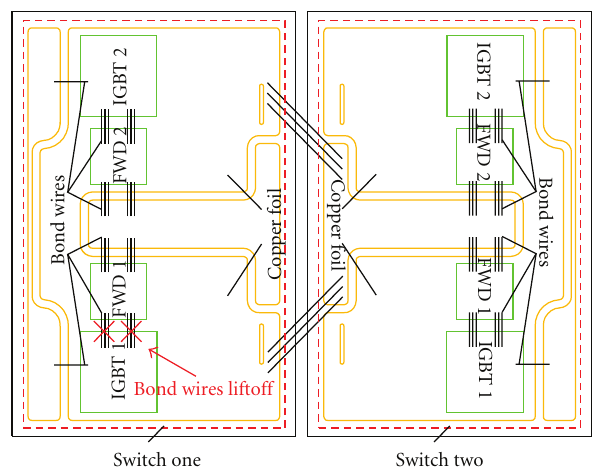
Figure 4: Bond wires lifto ff inside an IGBT